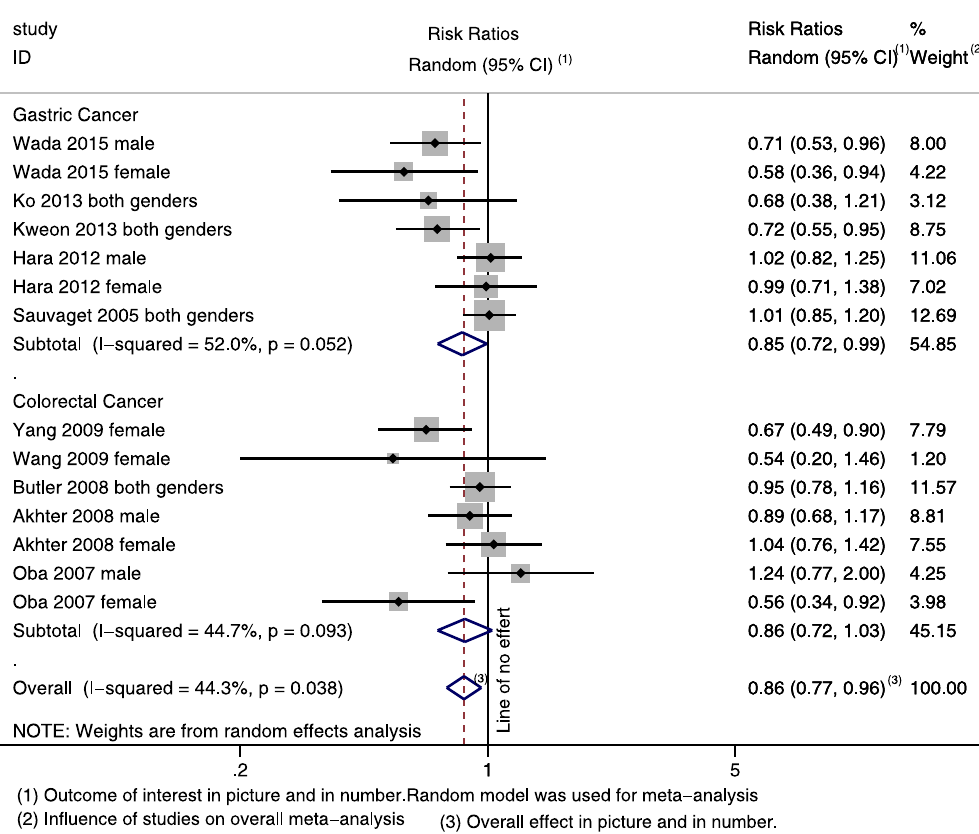
Figure 2. Forest plot and summary risk estimates for both genders of the association between soy product intake and incidence of GI